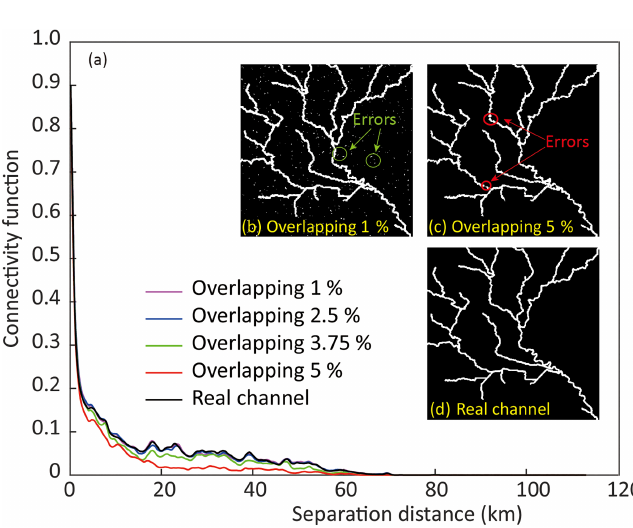
Figure A3. (a) Connectivity function in the northwest to southeast direction when applying the trained SRCNN to generate synthetic pale- ovalleys. Resultant paleovalley patterns using trained SRCNN with various degrees of overlap (1% b and 5% c ) in comparison with a real paleovalley (d) .